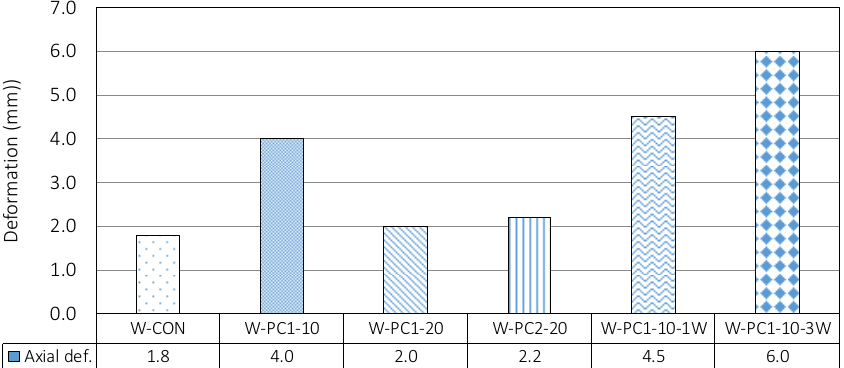
Figure 18. Deformation of CCIHBM walls.